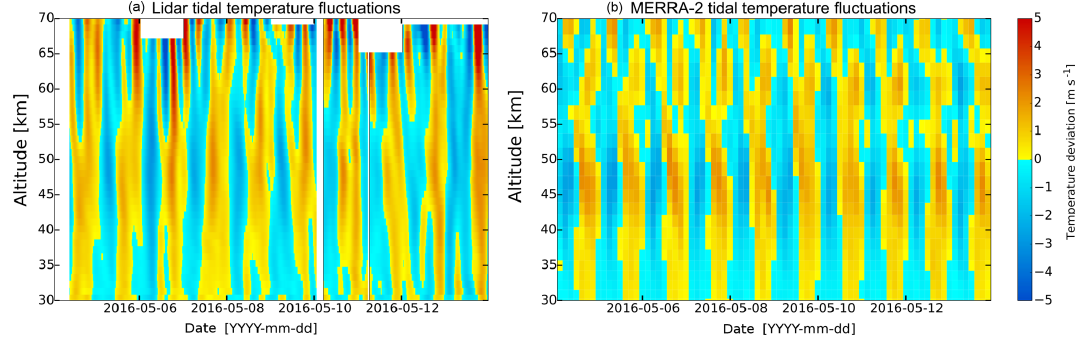
Figure 2. Tidal temperature fluctuations from the lidar (a) and from MERRA-2 (b) on 4–13 May